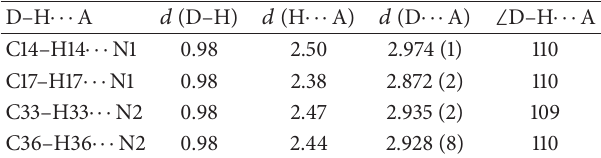
Table 3: Hydrogen bond geometries for 2 (˚A, ∘